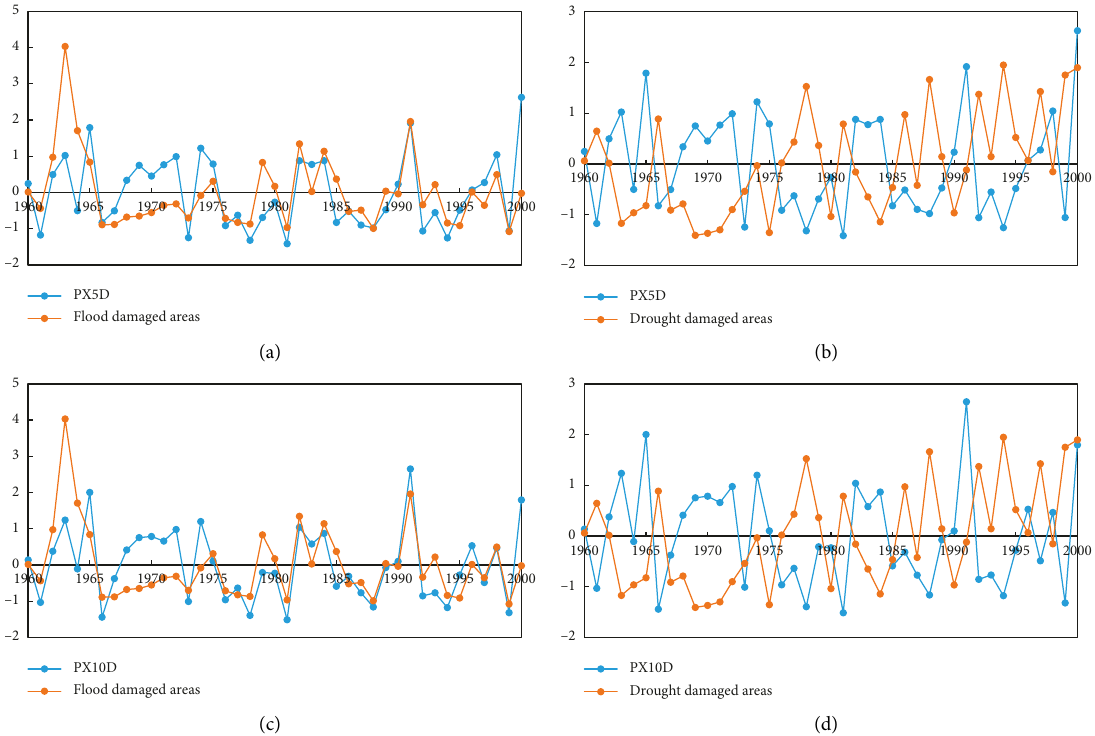
Figure 4: Relation between PX5D/PX10D and flood/drought damaged areas in the HRB (standardized series): (a, c) flood damaged areas (b, d) drought damaged